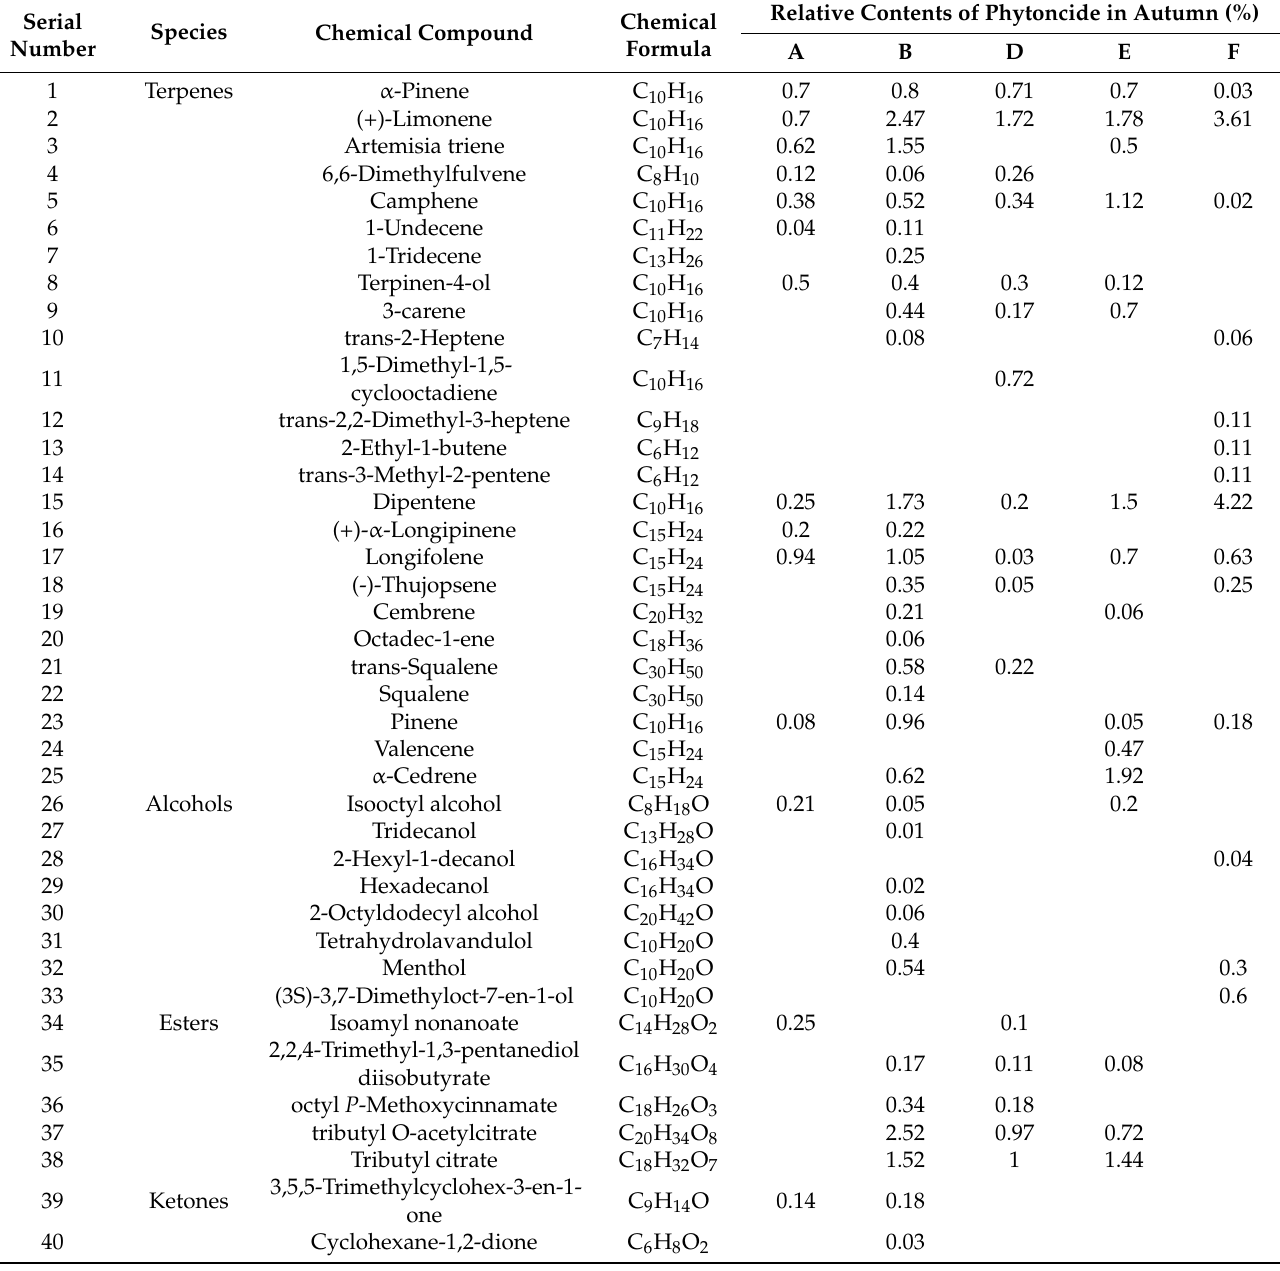
Table 6. Relative content of phytoncide